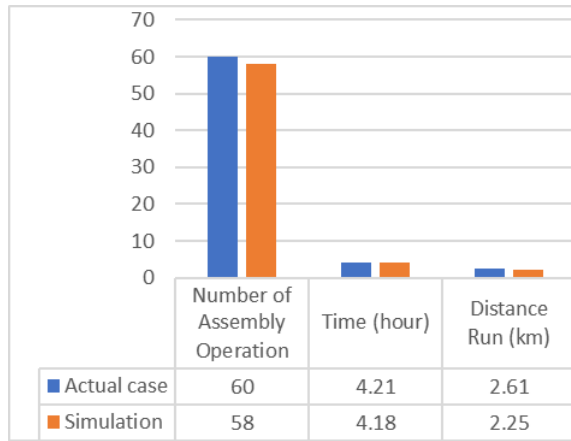
Figure 9. Comparison simulation vs. experiment